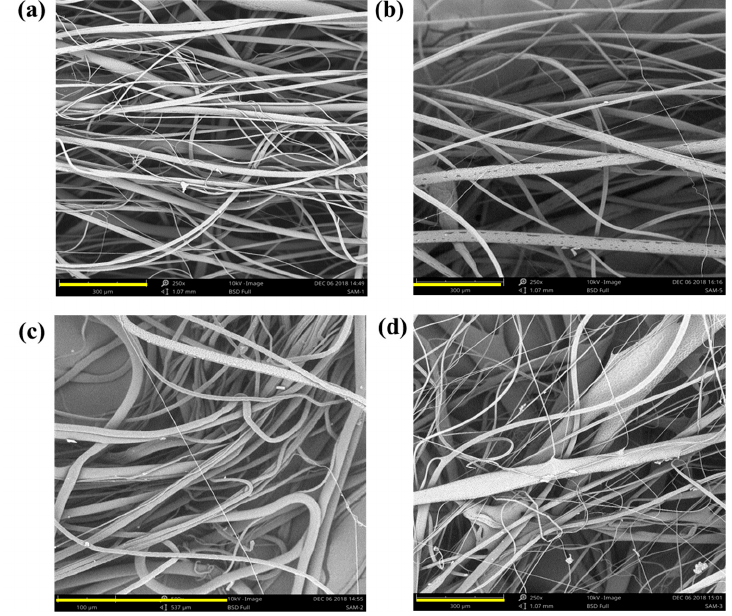
Figure 2. SEM images of c ‐ spun PCL and PCL ‐ CA fibrous mats. ( a ) PCL without heating, ( b ) PCL with heating, ( c ) PCL ‐ CA without heating, and ( d ) PCL ‐ CA with heating. Scale bar is 300 μ m.